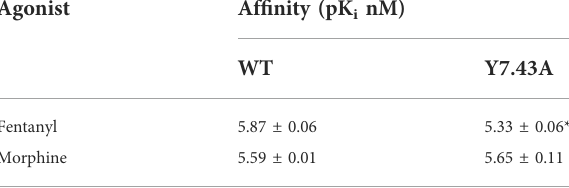
Af fi nityisrepresentedasaveragepKi±standarderrorofthemean( n =3)derivedfrom fl uorescent ligand competition binding in membranes from cells expressing WT and Y7.43A mutant MOR from three experiments performed in duplicate. *p < 0.05, compared with WT group. WT, wild type; MOR, µ-opioid